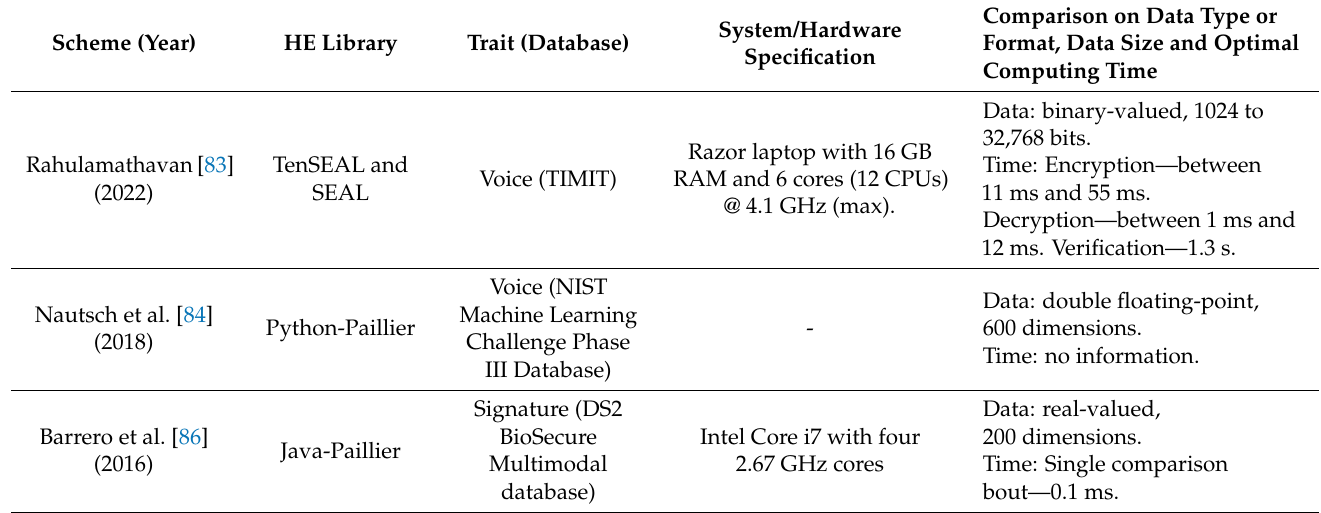
Table 5. Comparison of HE-based approaches to voice security and signature security in terms of computational efficiency.